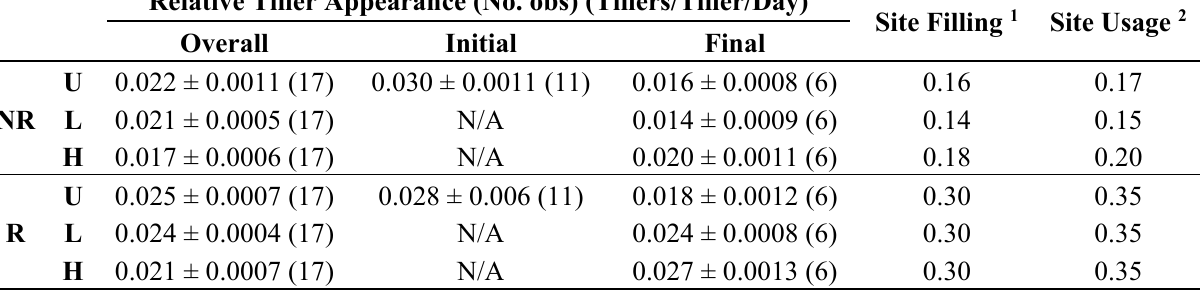
Table 3. Effect of defoliation on relative tiller appearance (for initial and final stages of development, ± standard error), and calculated rates of site filling and site usage. Data are for non-rhizomatous (NR) or rhizomatous (R) populations undefoliated (U) or under lax (L) or hard (H)